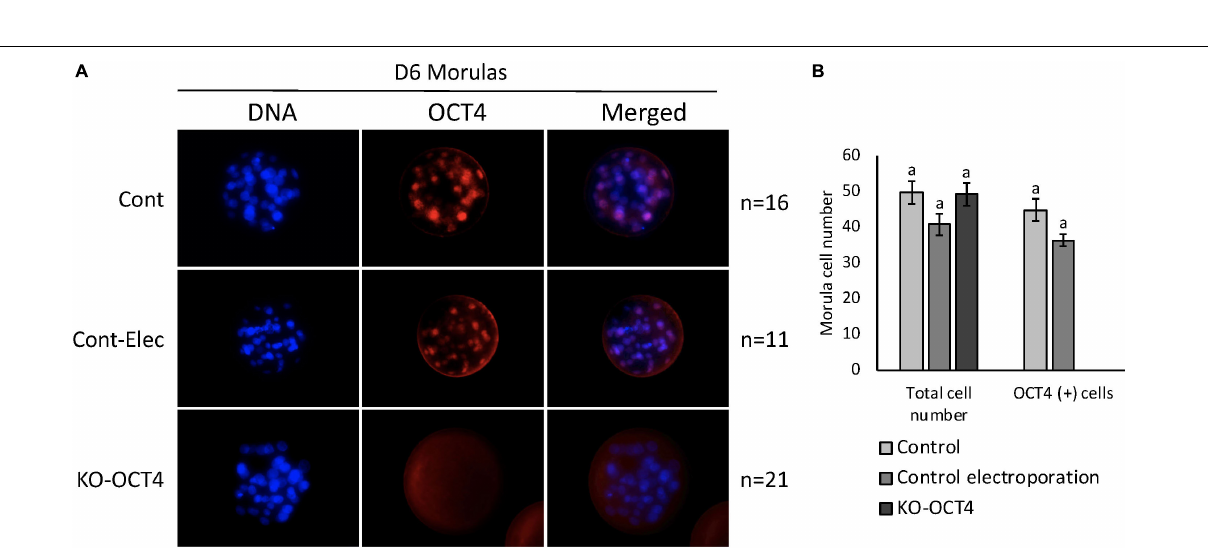
FIGURE 5 | Zygote electroporation with RNPs targeting OCT4 eliminated OCT4 expression in morula stage embryos. (A) Immunofluorescence analysis of OCT4 expression in morulas collected 144 h post in vitro fertilization (D6) in control (Cont), control electroporation (Cont-Elect) and OCT4-targeting RNPs electroporation (KO-OCT4) groups. (B) Number of total cells and cells expressing OCT4 (OCT4 + ) in morulas collected 144 h after in vitro fertilization. n: number of embryos evaluated in each group. No statistical difference in total cell number detected between groups ( P > 0.05). No statistical difference in OCT4 + cell between control groups. No OCT4 + cells found in any morula analyzed in KO-OCT4